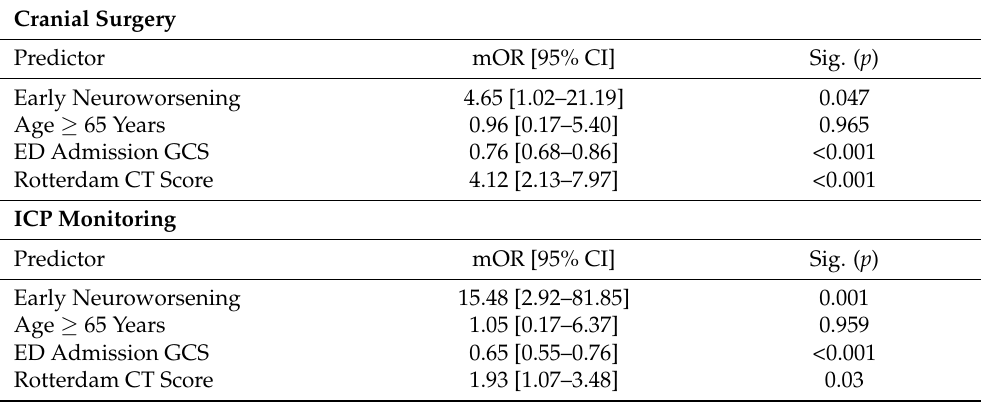
Table 3. Multivariable regression for interventions and outcomes. Multivariable binary logistic regressions were performed for four dependent measures: cranial surgery, ICP monitoring, 3-month unfavorable outcome, and 6-month unfavorable outcome. Unfavorable outcome was defined as Glasgow Outcome Scale-Extended score of 1–3. Early neuroworsening was the variable of interest. Multivariable odds ratios (mOR) and their associated [95% confidence intervals (CI)] are shown for each per-unit increase of the predictor variable. CT = computed tomography; ED =